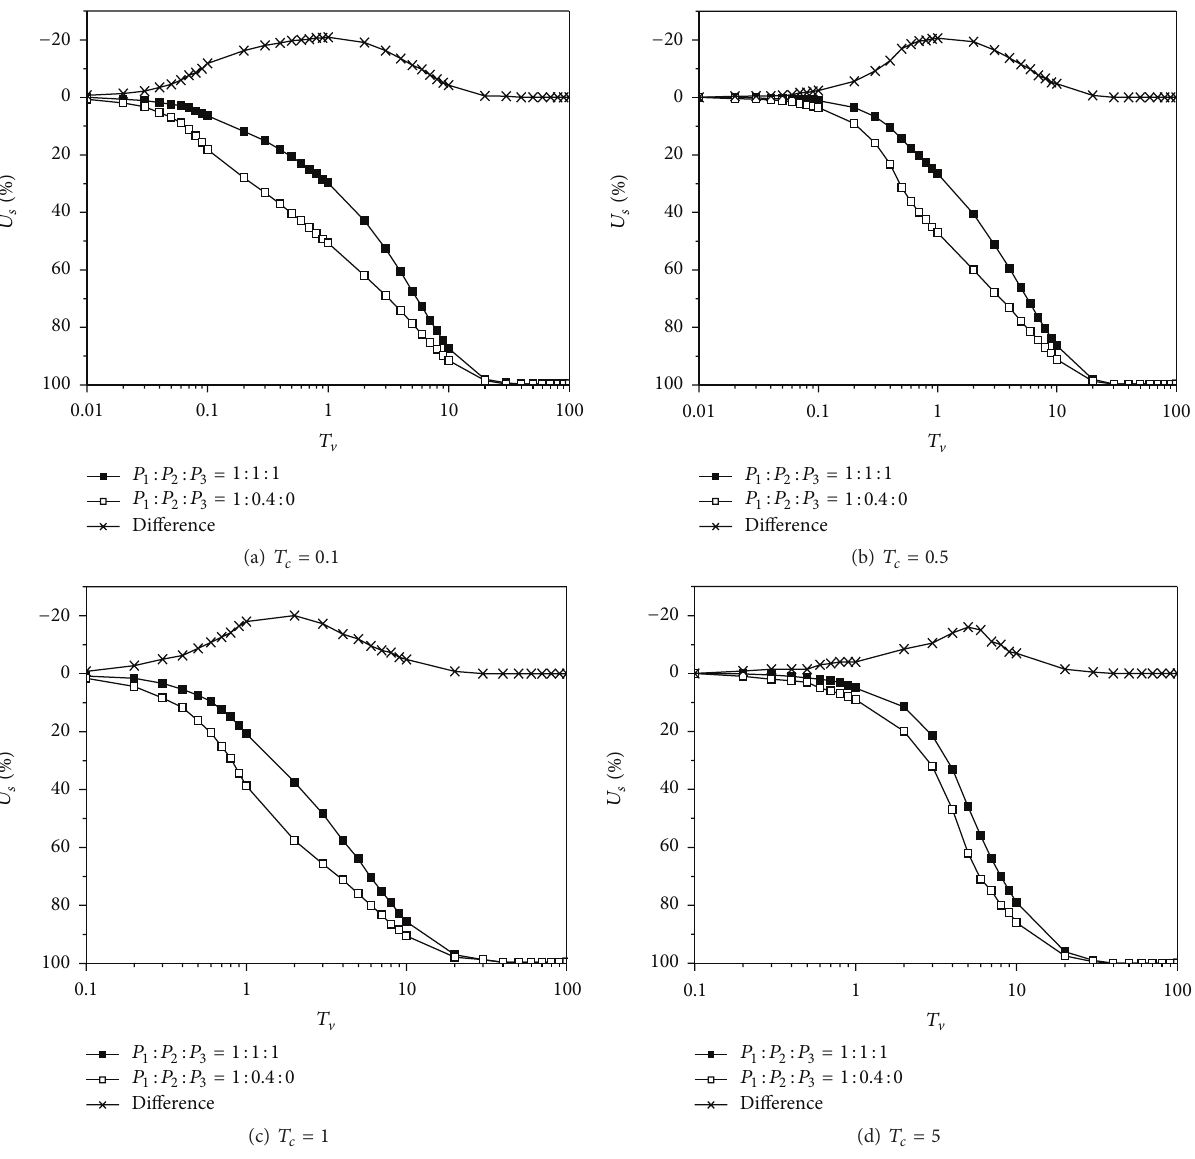
Figure 8: Consolidation curves with a single-drained